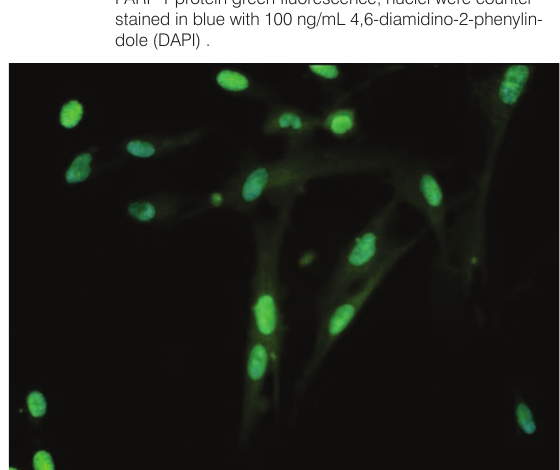
Figure 1. Immunofluorescence of fibroblasts obtained from oral biopsy of periodontal gingival tissue in DS male subject, PARP-1 protein green fluorescence, nuclei were counter- stained in blue with 100 ng/mL 4,6-diamidino-2-phenylin - dole (DAPI) .